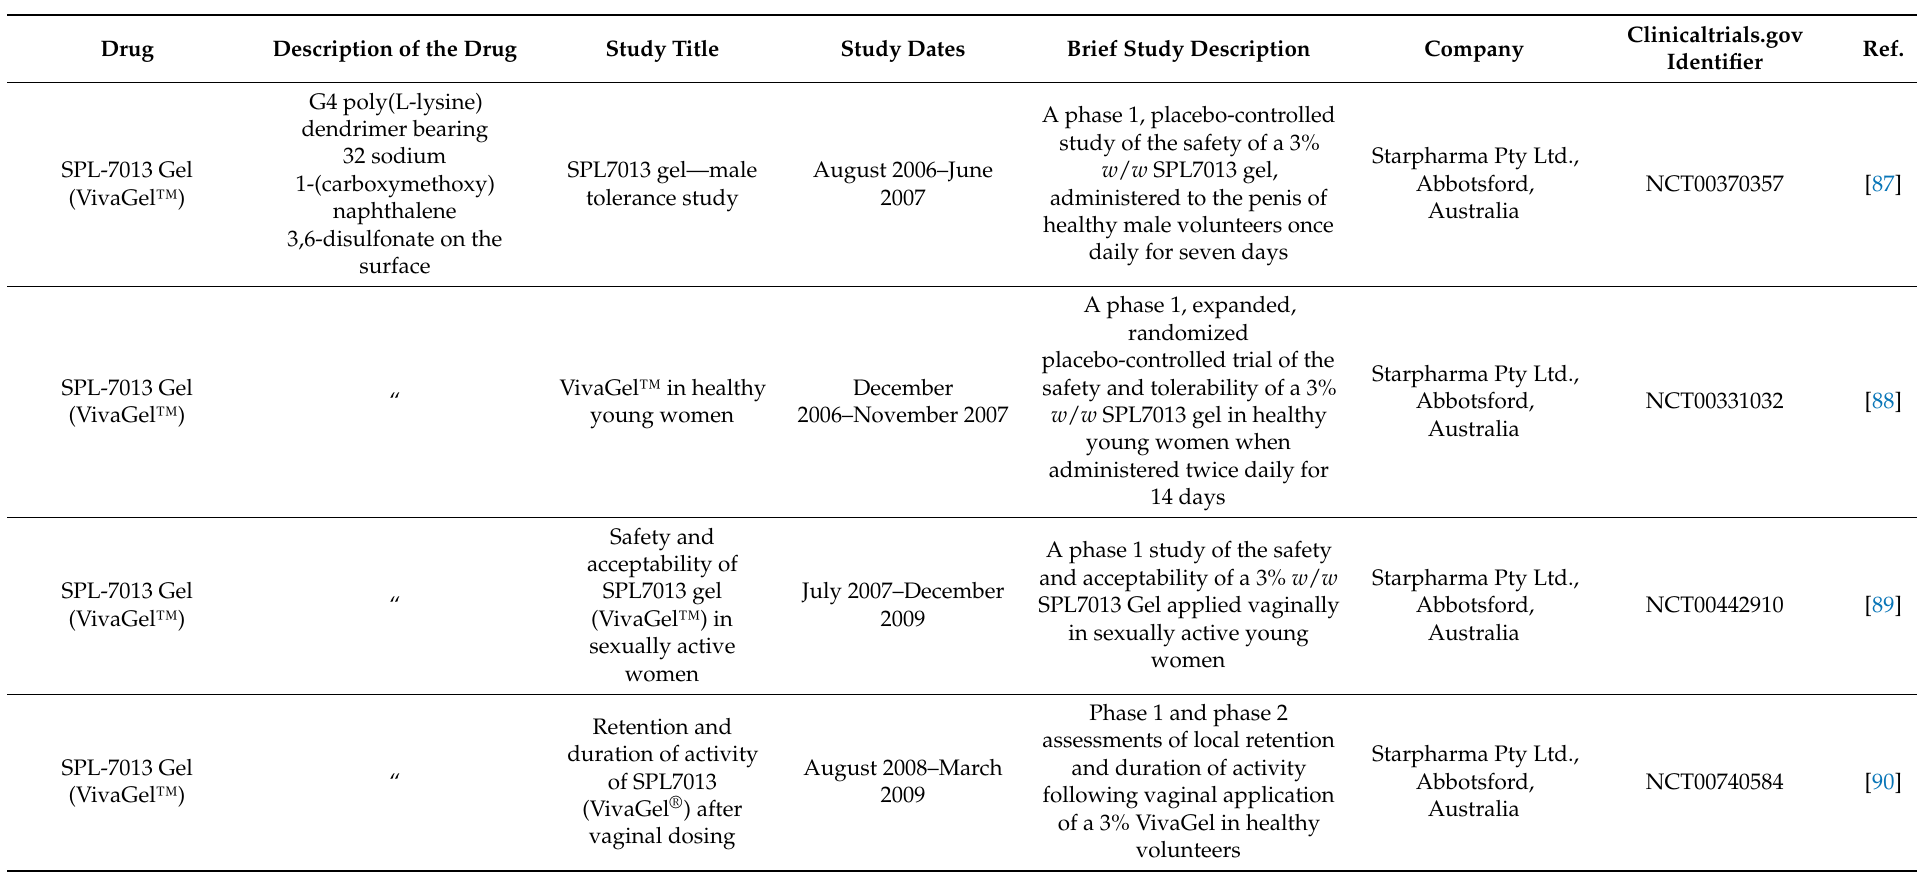
Table 1. Dendrimer-based drugs in clinical